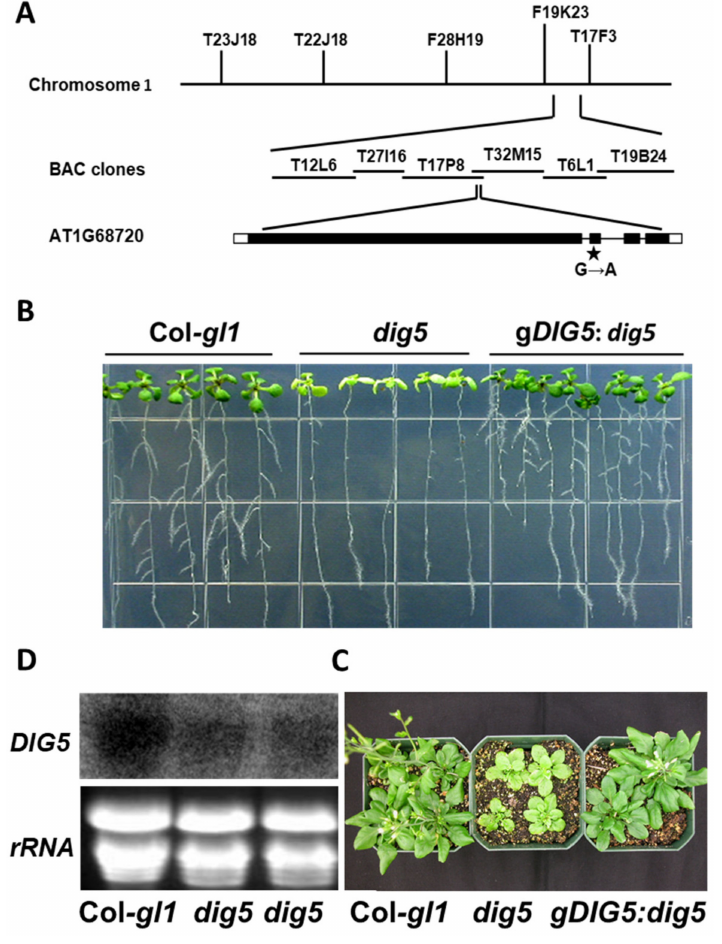
Figure 6. Map-based cloning of the DIG5 locus and complementation of the dig5 mutants. ( A ) Map- based cloning of the DIG5 locus. After delimiting the DIG5 locus to an interval of about 105 kb, DNA sequencing identified a single nucleotide mutation in the gene At1g68720 . ( B , C ) Complementation of the dig5 mutants with the wild type genomic DNA of At1g68720 . Shown are the wild type Col- gl1 , dig5 , and dig5 mutant transformed with the wild type DIG5 genomic DNA ( gDIG5:dig5 ) on agar plates ( B ) or in soil ( C ). ( D ) Expression level of the DIG5 gene in the wild type and dig5 mutant seedlings. Shown are RNA blotting of total RNA probed with the radiolabeled DIG5 probe (upper panel) and loading control of ethidium bromide stained rRNA (lower